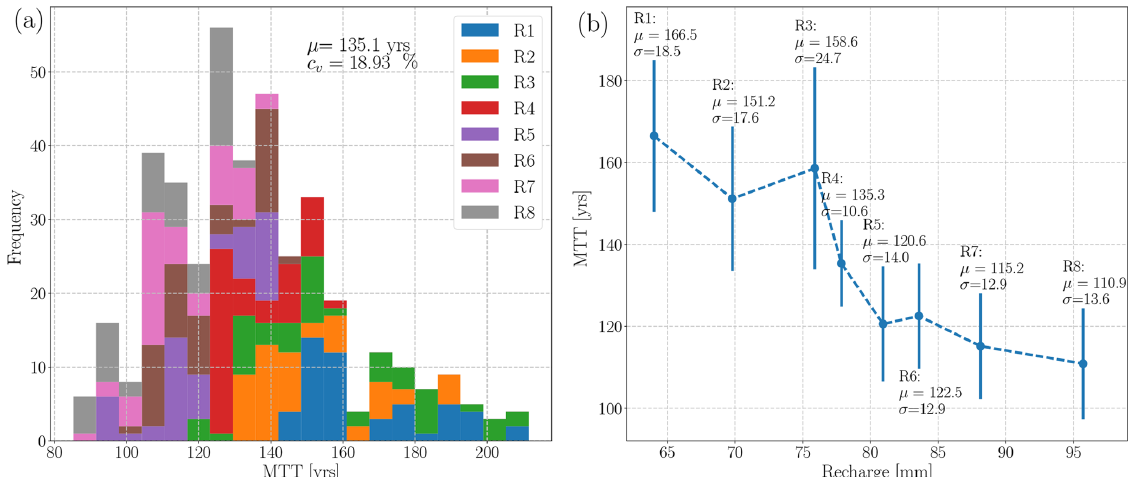
Figure 8. Uncertainty quantification: Monte Carlo simulations of MTT predictions categorized by recharge realization. (a) shows a histogram of MTT predictions. (b) shows the relationship between the ensemble-averaged MTT ( µ ) and the spatially averaged recharge. The error bars represent the standard deviation of MTTs ( σ ) for each recharge realization.